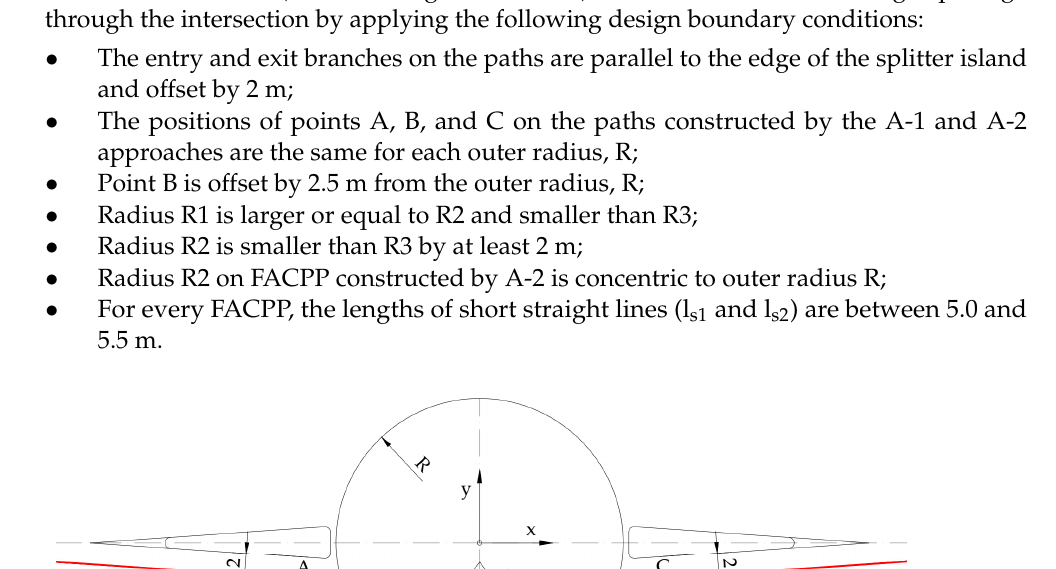
Figure 1. Elements of the tested roundabout scheme.